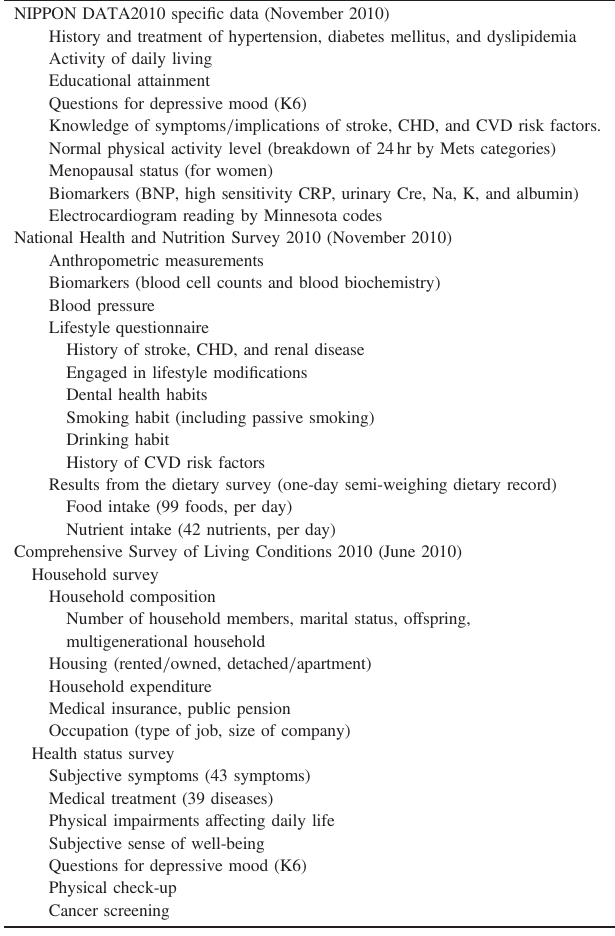
Table 1. Outline of the integrated NIPPON DATA2010 dataset, variables, and their original